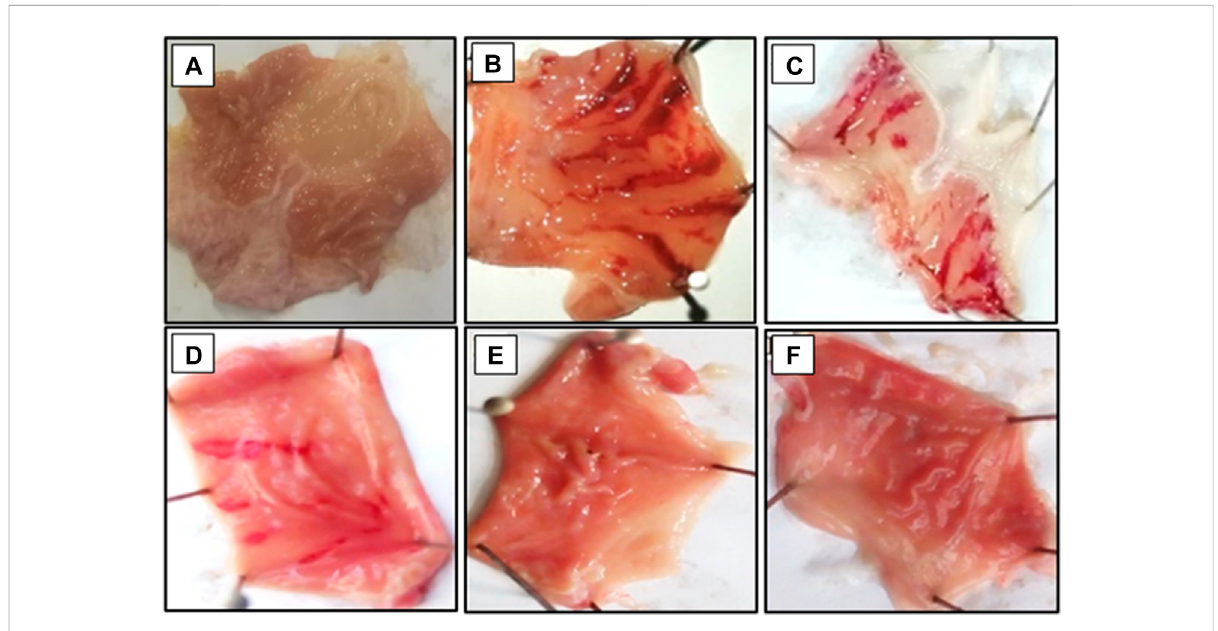
FIGURE 6 Gross-appearanceofgastricmucosainrat: (A) pre-treatedwithsaline,10 mL/kg, (B) Severeinjuriesareseen,asethanol(1 mL/100 g)produced excessive hemorrhagic necrosis of gastric-mucosa (C – E) pretreated with bergapten at doses of 100, 150, and 200 mg/kg and (F) pretreated with omeprazole (20 mg/kg). The injuries reduce with increase of doses and omeprazole compare with ethanol treated group. At 200 mg/kg, bergapten showed most ef fi cacious gastro- protective